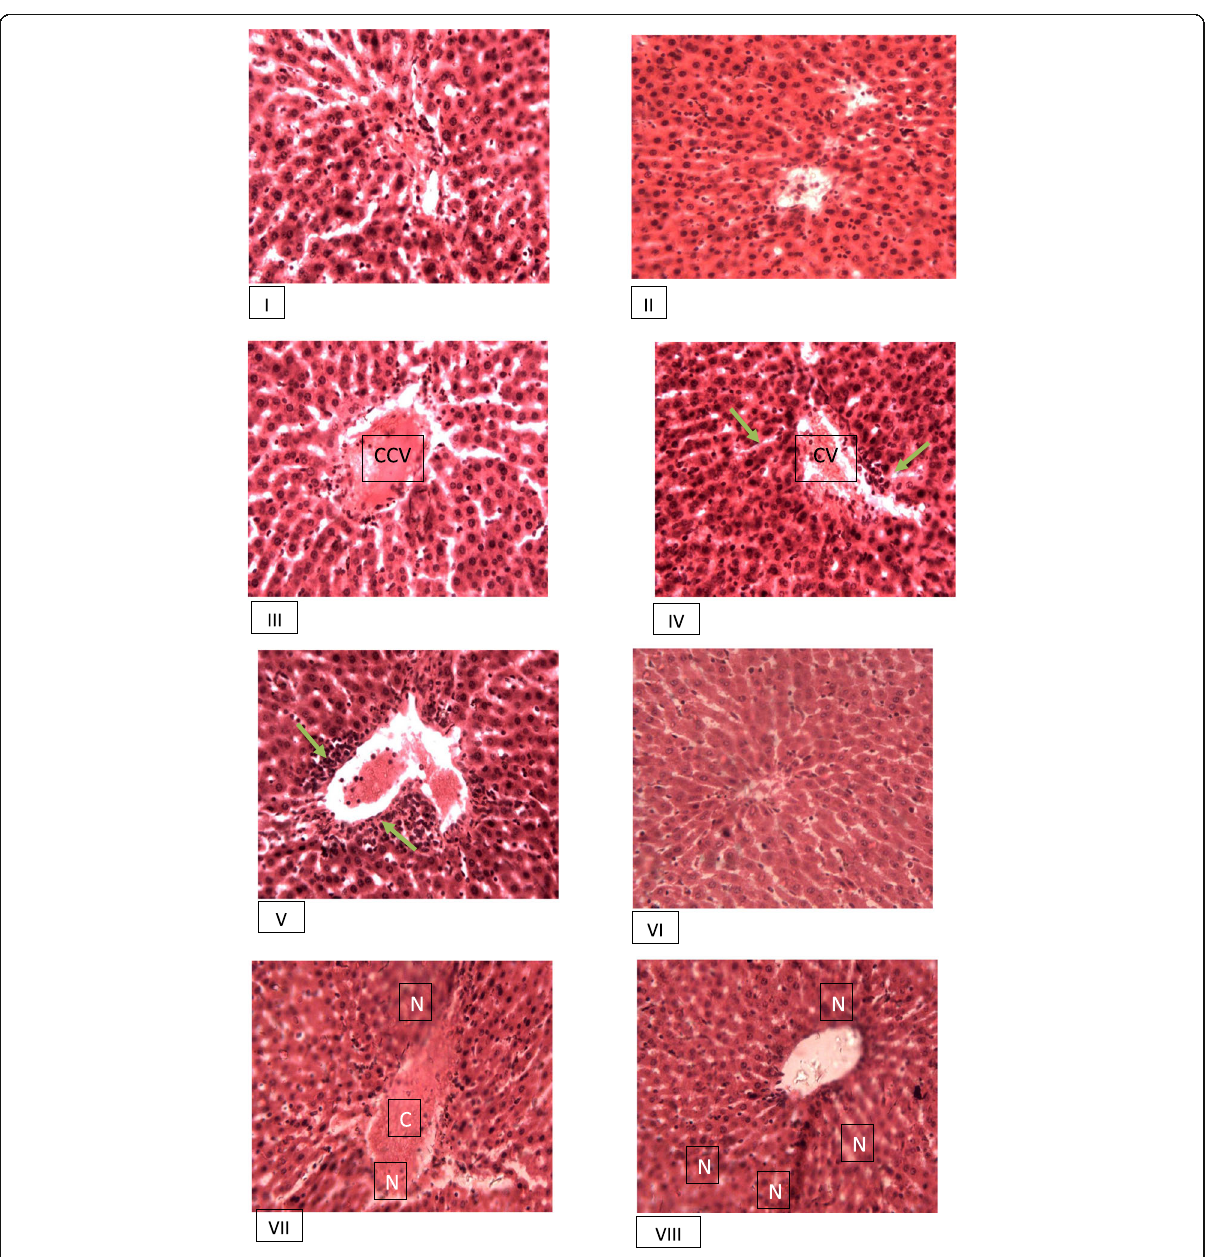
Fig. 1 Histological sections of liver showing varying degrees of pathologies. I: rats administered distilled water showing normal hepatocytes. II: hepatocytes of rats treated with extracts of Azadirachta indica showing no pathology. III: congested central vein (CCV); IV: congestion and occluded sinusoids (arrow heads), with no communications with the central vein (CV); V: congestion and mononuclear cell infiltration (arrows); VI: degenerative hepatocyte; VII: congestion (C) and necrosis at 12 and 6 O ’ clock (N) and VIII: foci necrosis